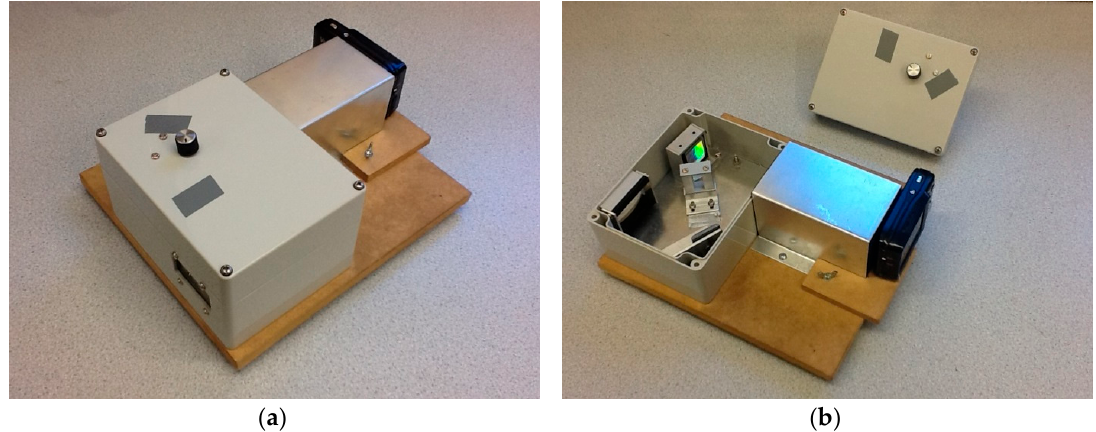
Figure 1. Photographs of the prototype sensor PHYLIS (Portable Hyperspectral Low-cost Imaging System): ( a ) PHYLIS with the optical equipment enclosed, as it is used in the field; ( b ) PHYLIS with the lid removed, showing the optical components.